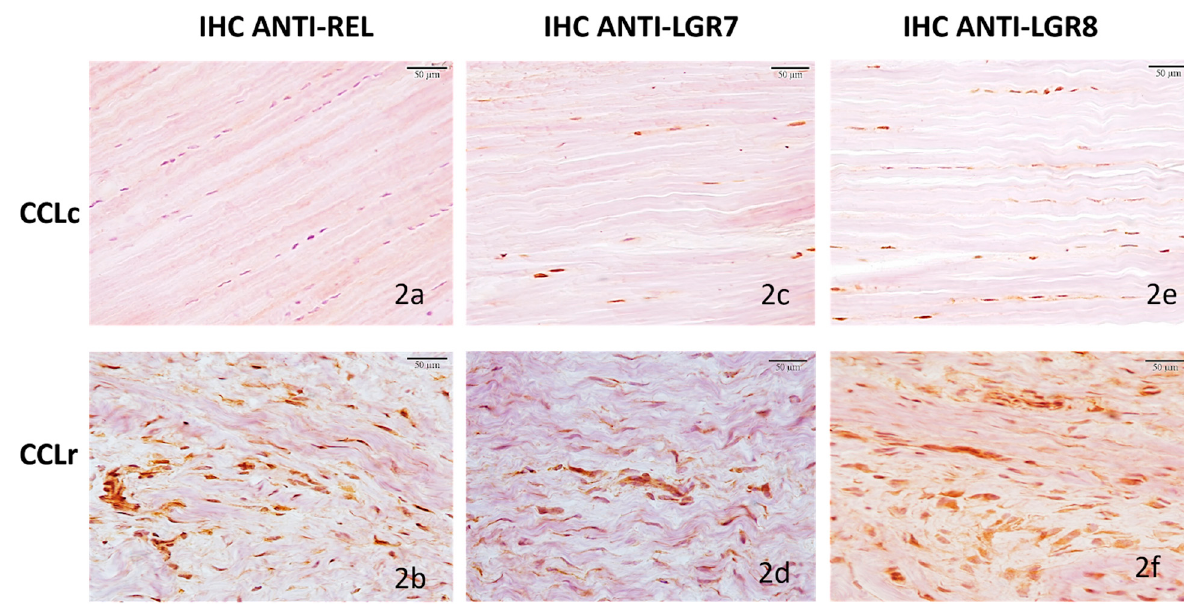
Figure 2. Immunohistochemical labeling of relaxin, LGR7, and LGR8 receptors in canine cruciate ligaments; controls (CCLc) and ruptured ligaments (CCLr): ( a ) CCLc, case 5, relaxin IHC, IRS = 1, weak, diffuse cytoplasmatic immunoreactivity in 9.5% of fibrocytes. ( b ) CCLr, case 17, relaxin IHC, IRS = 9, strong immunoreactivity, characterized by few, small cytoplasmic granules in 38.4% of fibroblast-like cells. ( c ) CCLc, dog 6, LGR7 IHC, IRS = 4, moderate immunoreactivity localized on cell membranes in 12.7% of fibrocytes. ( d ) CCLr, case 17, LGR7 IHC, IRS = 6, moderate immunoreactivity, characterized cytoplasmic granules in 38.5% of fibroblast-like cells. ( e ) CCLc, dog 6, LGR8 IHC, IRS = 2, moderate diffuse cytoplasmatic immunoreactivity in 10.7% of fibrocytes. ( f ) CCLr, case 17, LGR8 IHC, IRS = 9, strong immunoreactivity, diffuse and cytoplasmatic in 48.4% of fibroblast-like cells. Scale bars 50 μ m.